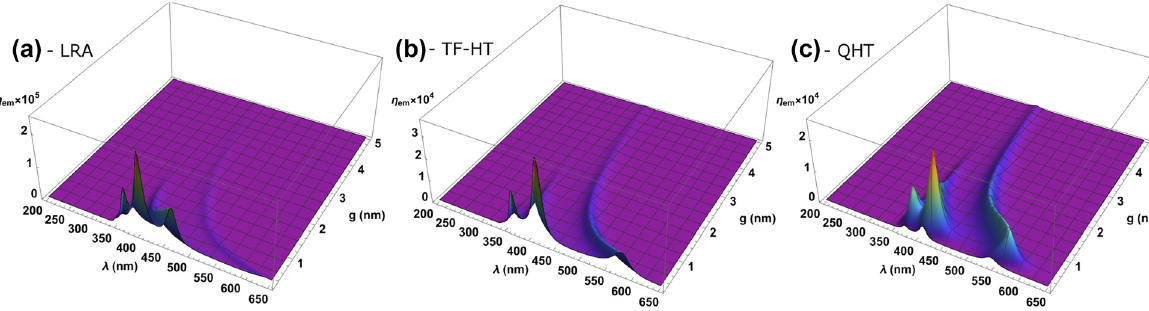
Figure 5: The dependence of the fluorescence enhancement for R = 10 nm gap size g and the wavelength 𝜆 as computed from LRA, TF-HT and